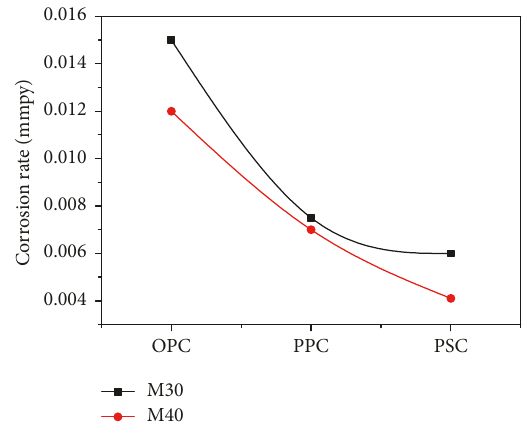
Figure 6: Comparison of corrosion rate of rebar in OPC, PPC, and PSC concrete types obtained by impressed voltage test (28-day cured specimens).